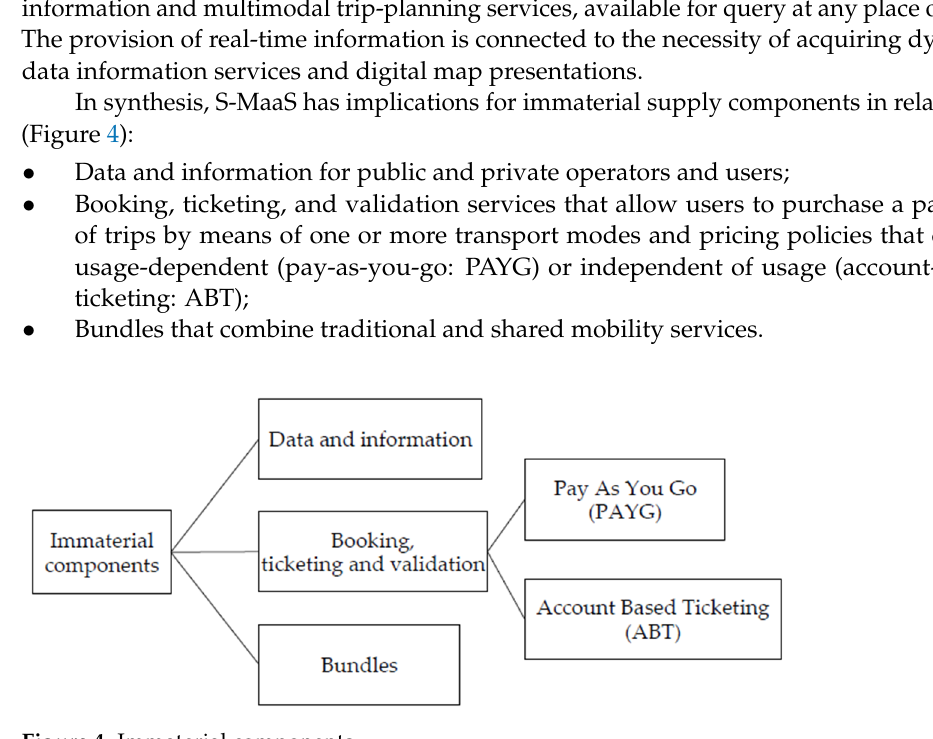
Figure 4. Immaterial